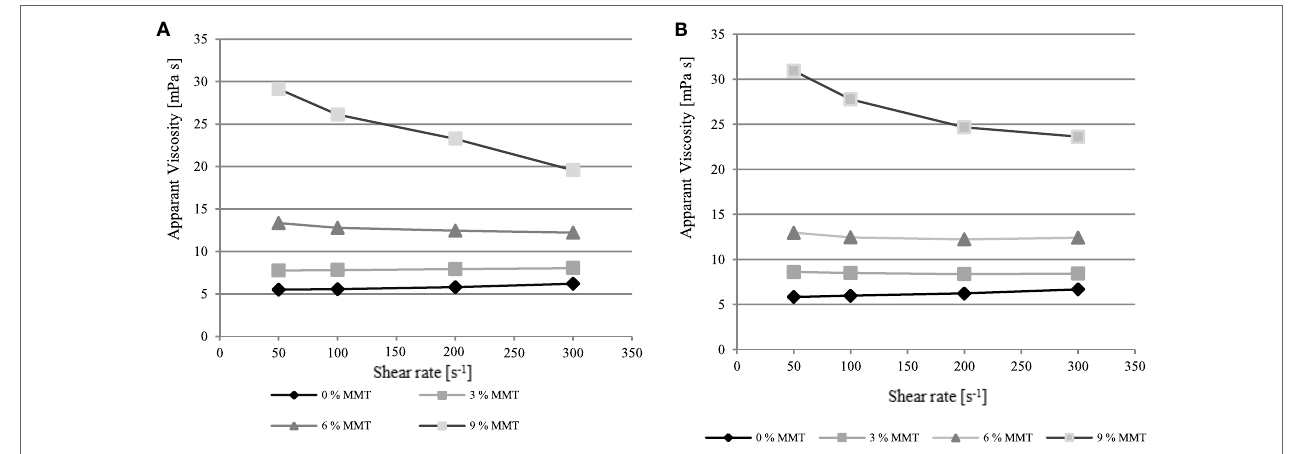
FigUre 2 | Apparent viscosity dependent on the shear rate from 50 to 300 [s − 1 ] of native whey protein isolate (WPI)-based nanocomposite dispersions with 15% (w/w) WPI, 66.70% (w/w protein), and an increasing montmorillonite (MMT) nanofiller loading, plasticized with (a) glycerol or (B)